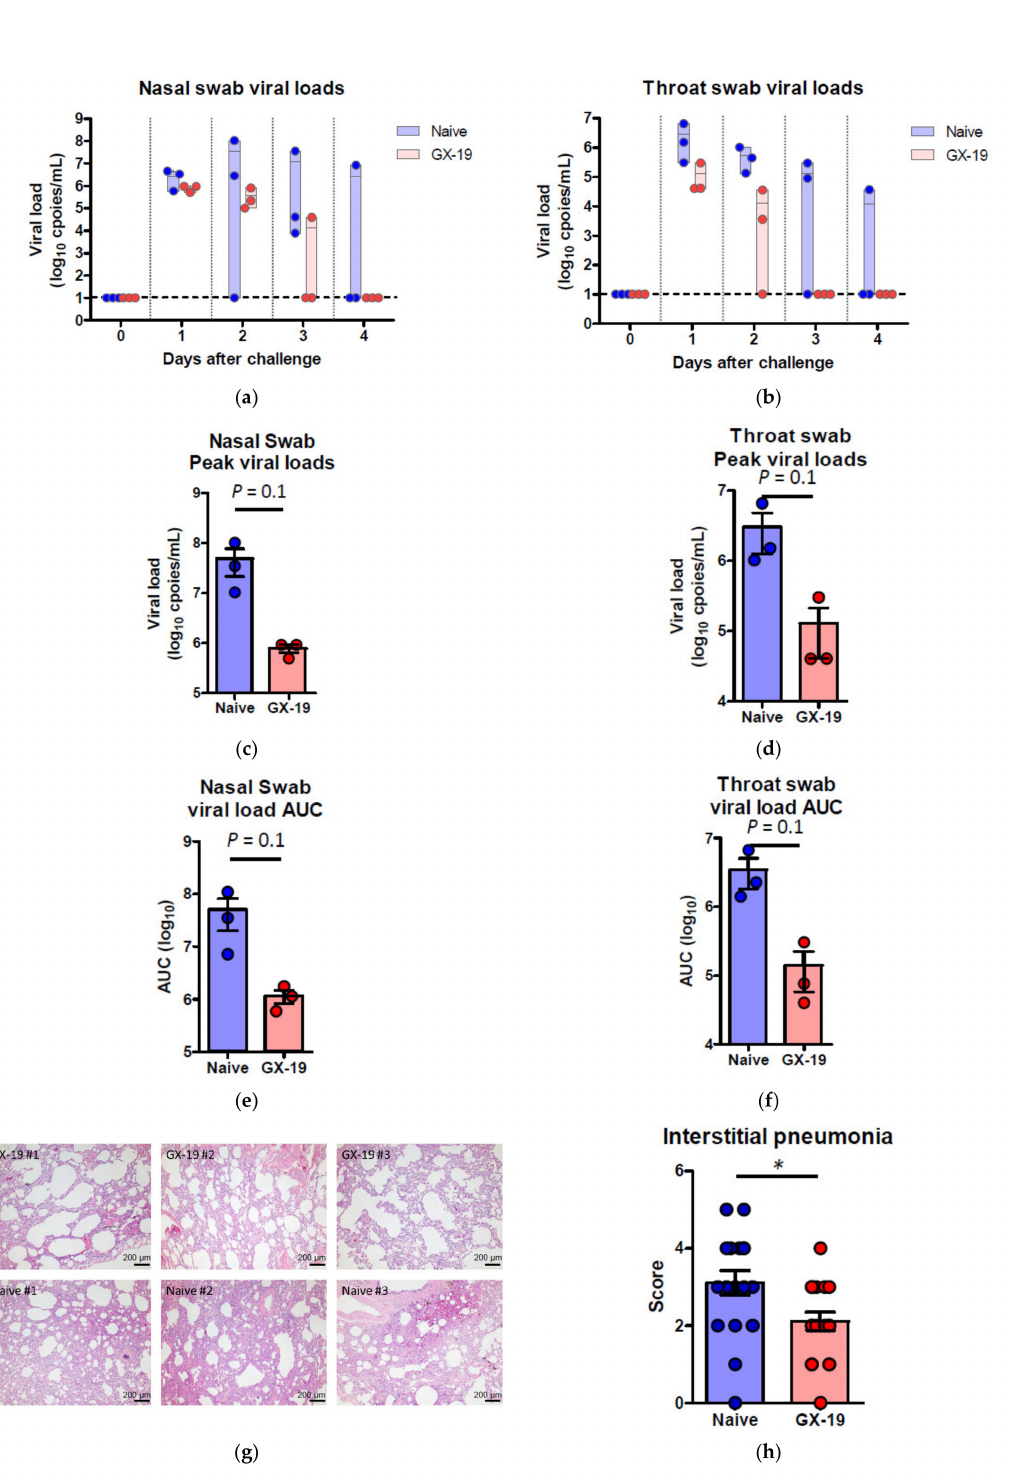
Figure 5. Protective efficacy of GX-19 against SARS-CoV-2 challenge. Non-vaccinated ( n = 3, blue) and GX-19-vaccinated macaques ( n = 3, red) were challenged by intratracheal, oral, conjunctival, intranasal, and intravenous administration of 2.7 × 10 7 TCID 50 SARS-CoV-2. Viral load was assessed in nasal swab ( a ) and throat swab ( b ) at multiple time points following challenge. Summary of peak viral loads and viral load area under the curve (AUC) in nasal swab ( c , e ) and throat swab ( d , f ) following challenge. Dashed line indicates the assay limit of detection. Histopathological changes in the lungs of SARS-CoV-2-challenged macaques ( g ). Interstitial pneumonia score by microscopic evaluation ( n = 6 lung lobes of each animal per group) ( h ). The lung tissue sections were stained with hematoxylin and eosin (H&E). Data of ( a – f ) are represented as individual values. Data of (h) is represented as 6 lung lobes of each animal per group. p -Values determined by the Mann–Whitney test; p -values are shown * p < 0.05 as determined by the Mann–Whitney